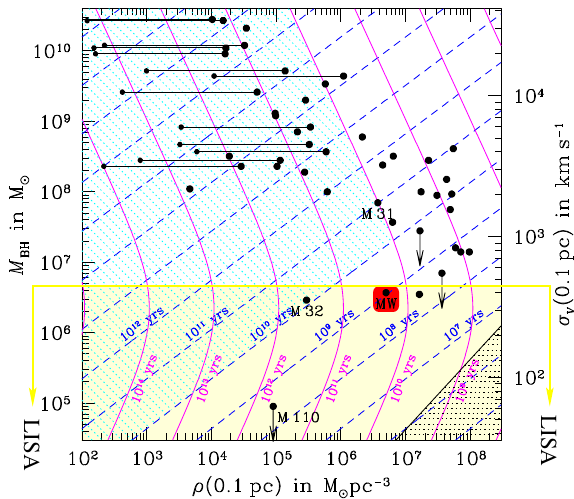
Fig. 18 Plane of the stellar density at 0.1pc and the mass of the central MBH. Relaxation (and collision times) at 0.1pc from an MBH in the centre of a galactic nucleus. Image adapted from Freitag and Benz